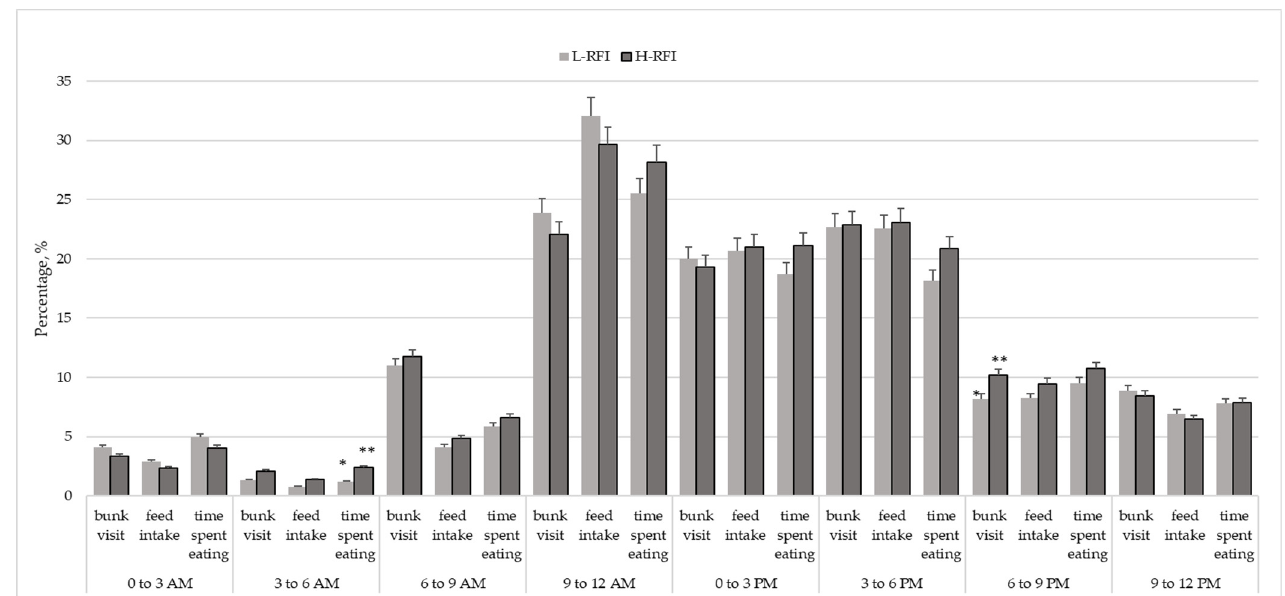
Figure 1. Variation of bunk visit, feed intake and time spent eating of low and high RFI groups. RFI: residual feed intake. (different *, ** asterisks mark showed significant differences ( p < 0.1) between columns.